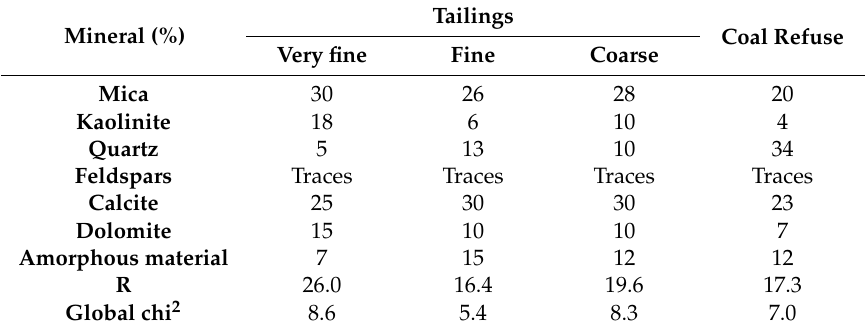
Table 1. X-ray diffraction (XRD) mineralogical analysis of the raw tailings samples.